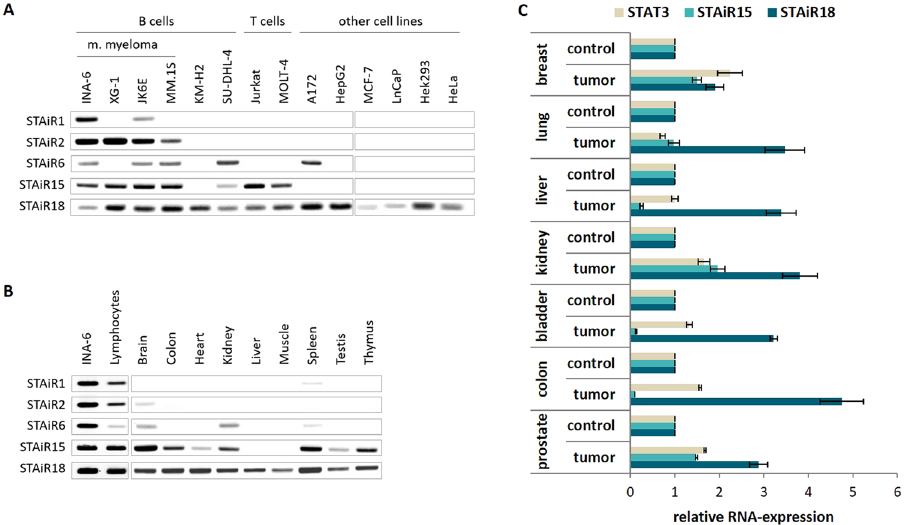
Figure 3. Tissue-specific expression of STAiRs. RNA was isolated from various ( A ) cell lines and ( B ) tissues. DNase-digested RNAs as well as Ambion’s FirstChoice ® Human Tissue Total RNAs were reverse-transcribed and subjected to standard PCR using primer pairs for primary STAiRs, resulting in product sizes of 264 bp for STAiR1, 253 bp for STAiR2, 271 bp for STAiR6, 252 bp and 625 bp for STAiR15.1 and STAiR15.2, respectively, as well as 330 bp and 106 bp for STAiR18.1 and STAiR18.2, respectively. Individual gel runs are indicated by gray boxes. Raw data images are displayed in Supplemental Fig. 2. ( C ) Differential expression of spliced STAiRs 15 and 18 transcripts in tumorous and according healthy control samples. DNase-digested total RNA was reverse- transcribed and subjected to qPCR using specific intron-spanning primers for STAiRs 15, 18, and STAT3. Expression values were normalized to U6 RNA and compared to the corresponding healthy control sample. Data are expressed as mean ± SD (n ≥ 3). STAiR18 expression was significantly (p < 0.05) elevated in every tumor sample